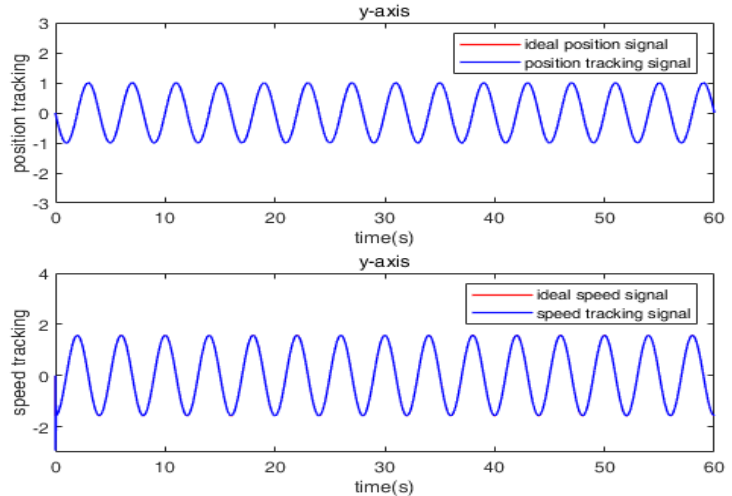
Figure 6. Position tracking and speed tracking of the y ‐ axis under NFTSMC ‐ GRFNN.